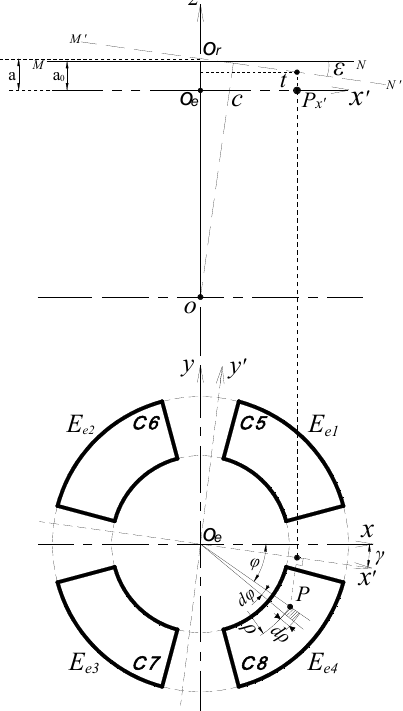
Figure 5. The calculation model of the tilt error motions.